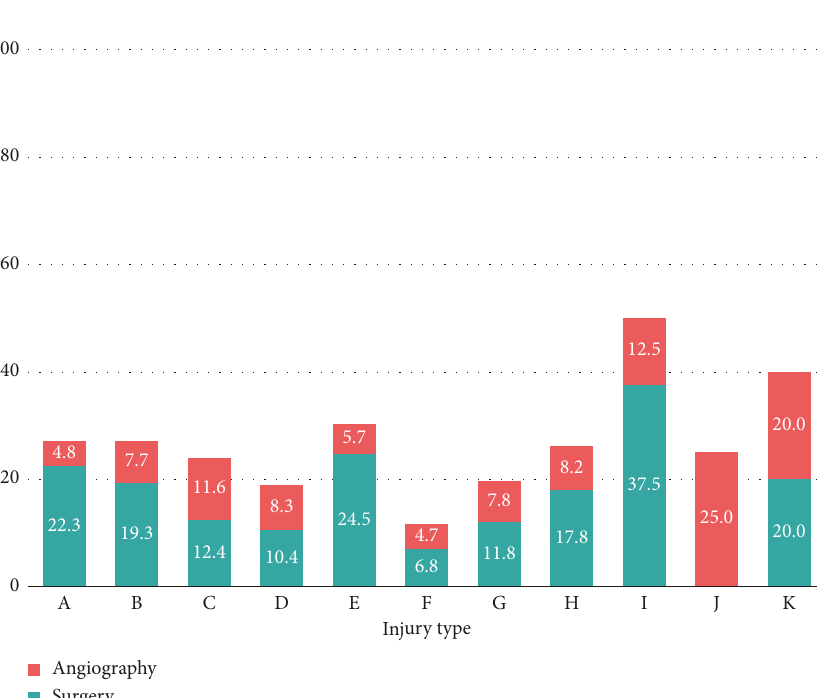
Figure 2: Ratio of surgery and angioembolization by each trauma mechanism. A, car accident; B, motorcycle accident; C, pedestrian accident; D, bicycle accident; E, ship or train accident; F, fall; G, slipping and rolling down; H, bumping injury; I, crush injury; J, explosion burn; K, others; 1, liver; 2, spleen; 3, bowel; 4, mesentery and omentum; 5, pancreas; 6, kidney; 7, bladder; 8,